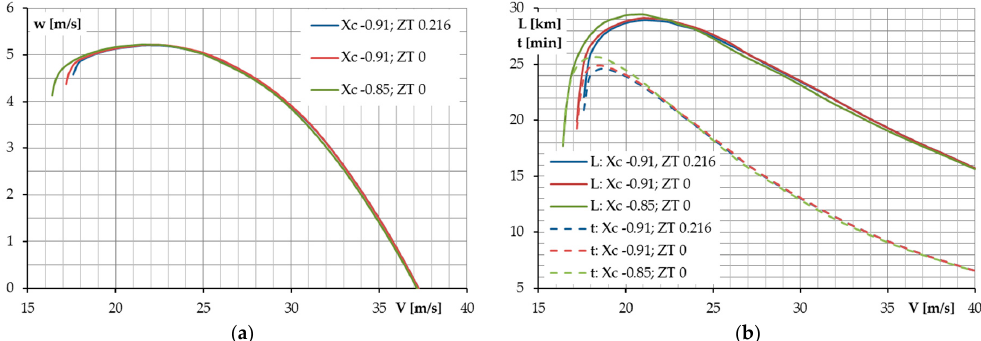
Figure 20. Variation in the airplane’s performance with the thrust vector position: ( a ) maximum climb rate; and ( b ) range and flight duration with respect to the airspeed.